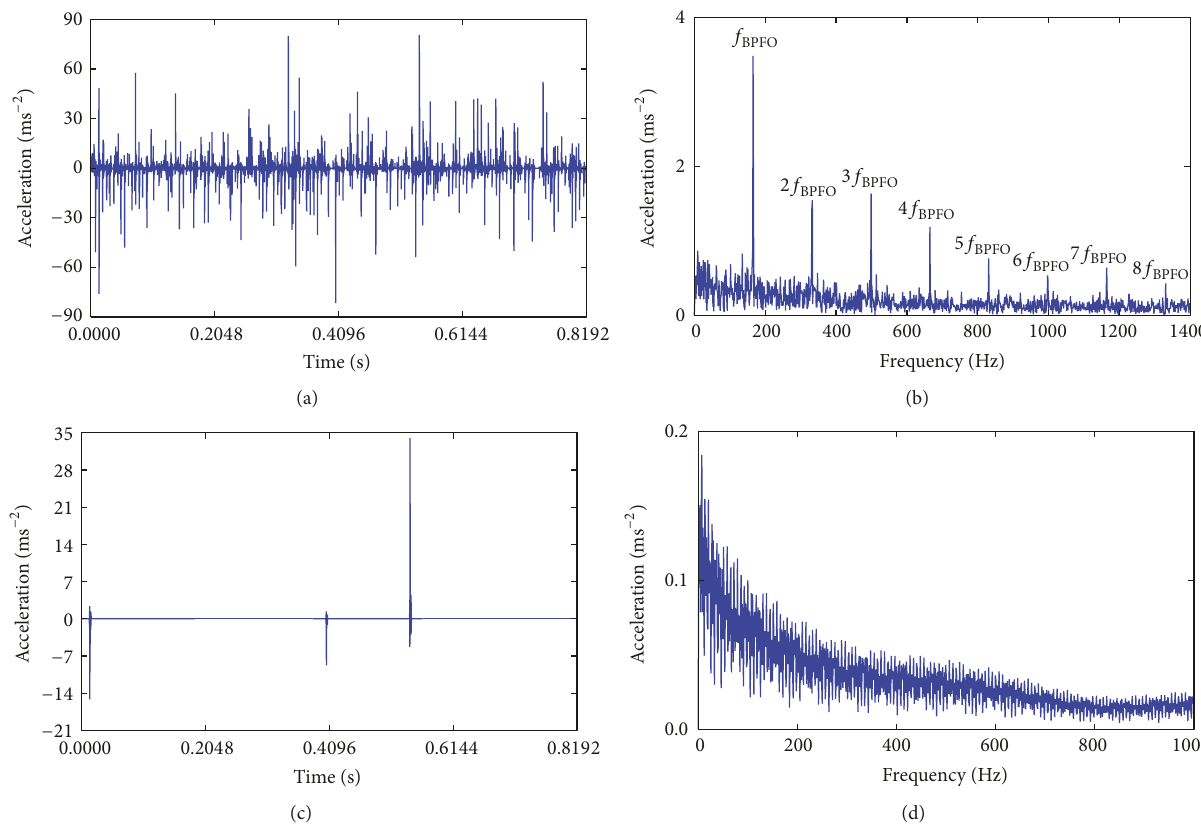
Figure 13: The extracted impulse: (a) by proposed appropriately sparse impulse extraction; (b) the envelope spectra of (a); (c) three other indicators; (d) the envelope spectra of (c).